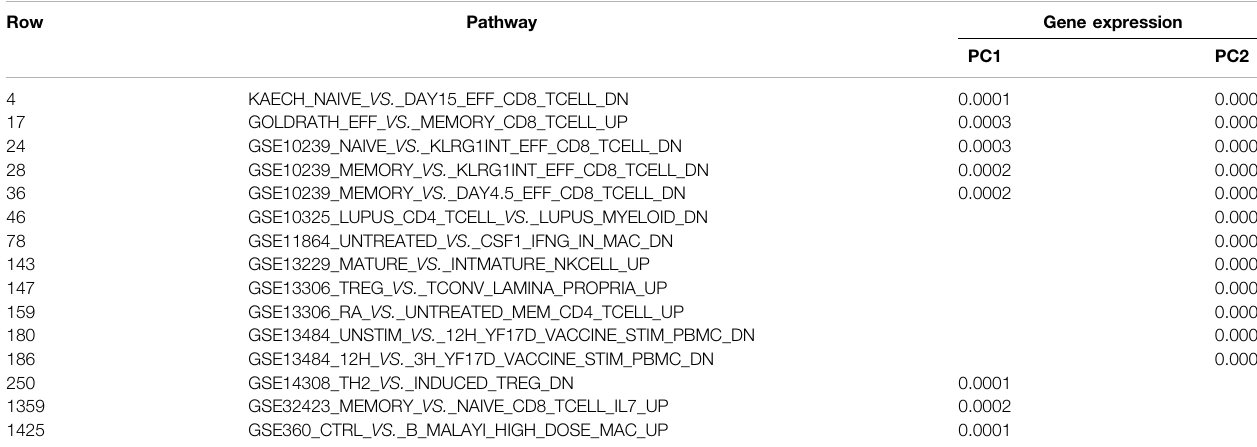
TABLE 2 | Key pathways associated with patients with the primary lung tumor symptoms.